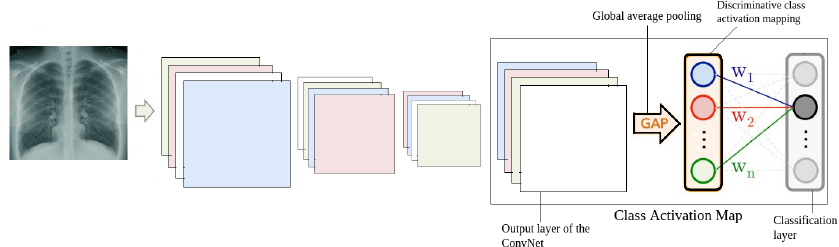
Figure 2. Conceptual view of class activation mapping; w 1 , w 2 ... w n represent the weights of the feature maps. Class activation mapping identifies the most relevant features in the input image used for